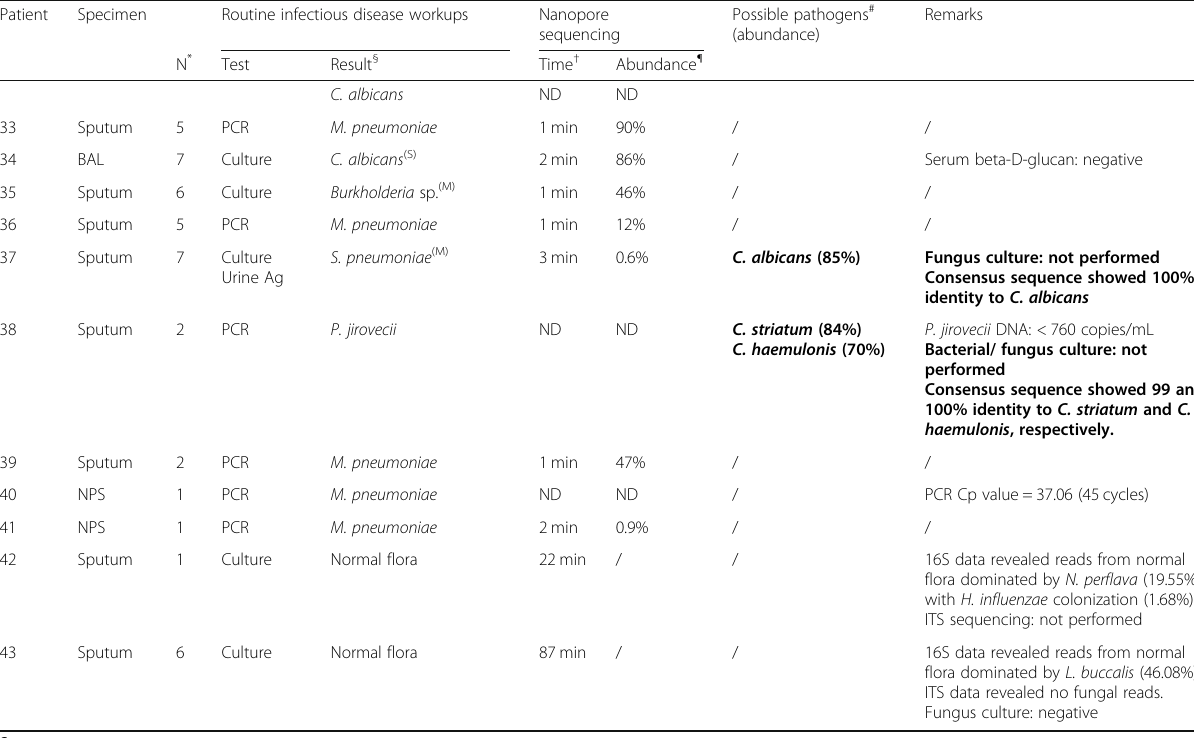
Table 1 Details of clinical specimens and results of Nanopore sequencing (Continued) Patient